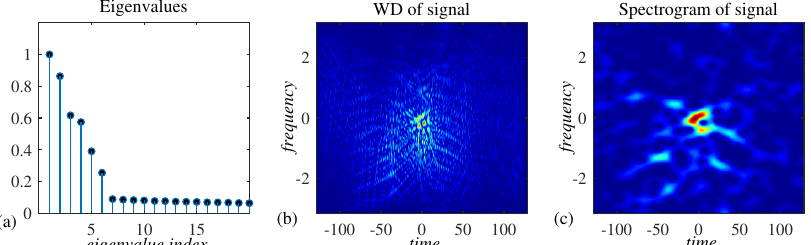
Figure 2. ( a ) Eigenvalues of autocorrelation matrix R , ( b ) Wigner distribution of the signal from Example 1 and ( c ) Spectrogram of the signal from Example 1. Signal consists of P = 6 non-stationary components. The signal is embedded in an intensive complex, Gaussian, zero-mean noise with σ ε = 1. The number of channels is C = 128. The largest six eigenvalues correspond to signal